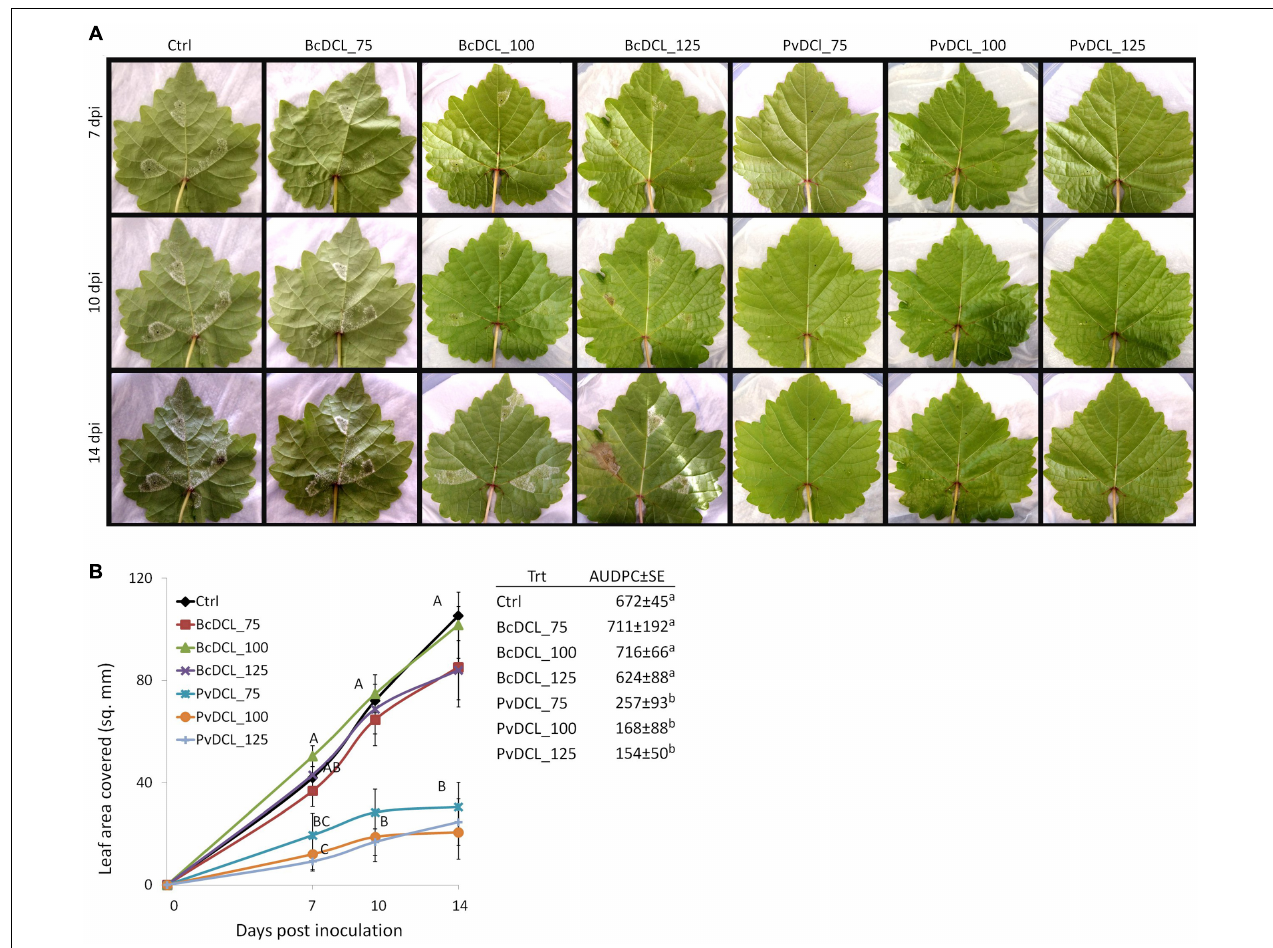
FIGURE 1 | Externally applied PvDCL1/2 double-stranded RNA (dsRNA) on detached grapevine leaves and Plasmopara viticola infection. (A) Progress of P. viticola on grapevine leaves at 7, 10, and 14 days post inoculation (dpi). Leaves were treated with 50 µ l of water (ctrl) or dsRNA [75, 100, or 125 ng µ l - 1 of dsRNA of BcDCL1/2 (BcDCL_75/100/125) and PvDCL1/2 (PvDCL_75/100/125)] before being inoculated with 7.5 µ l of a 1 × 10 5 ml - 1 sporangia. (B) Disease progression of P. viticola expressed as leaf area covered and as area under the disease progress curve (AUDPC ± SE, mm 2 × day) through 14 dpi. Error bars indicate standard error. Means at each dpi and AUDPC followed by a common letter are significantly not different according to Tukey’s honestly significant difference test ( P ≤ 0.05).